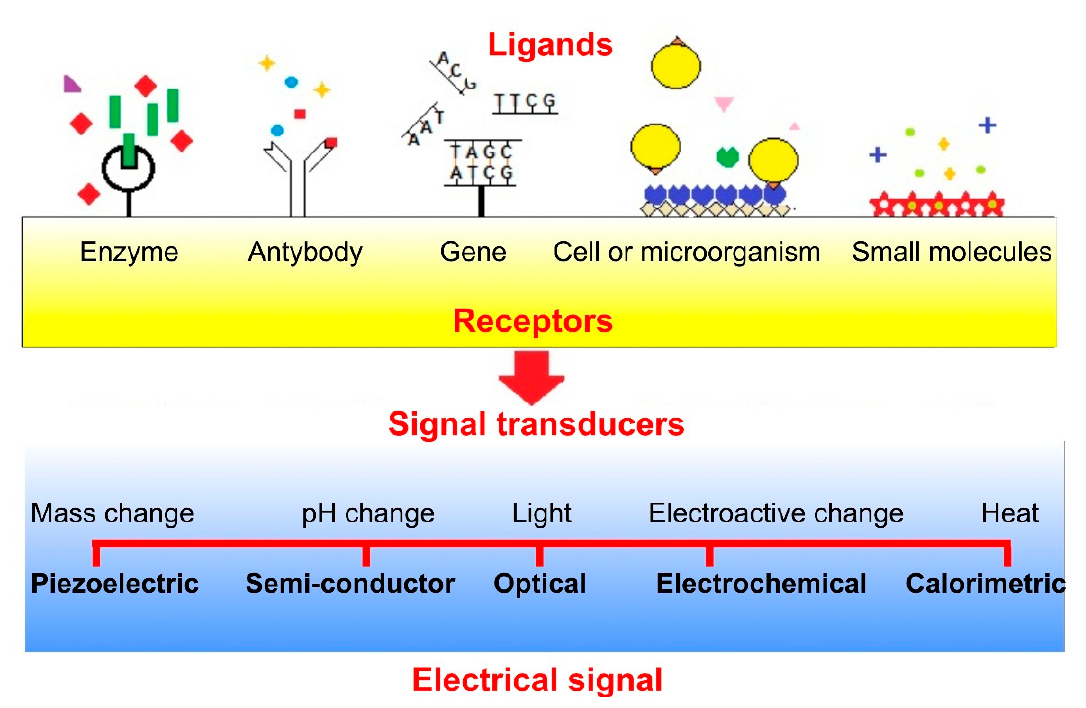
Figure 6. The illustration represents different mechanisms of biosensor activity; these bioreactions are carried out in a controlled environment on the immobilization platform. Depending on the generated signal, different transducing platforms are utilized to convert it into an electrical signal.